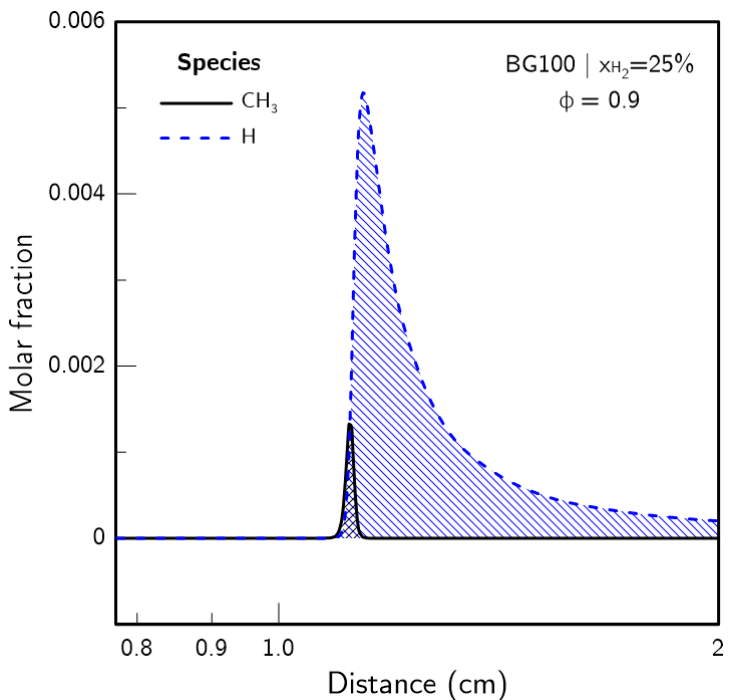
= 25% and φ = 0.9. The X axis is in 2